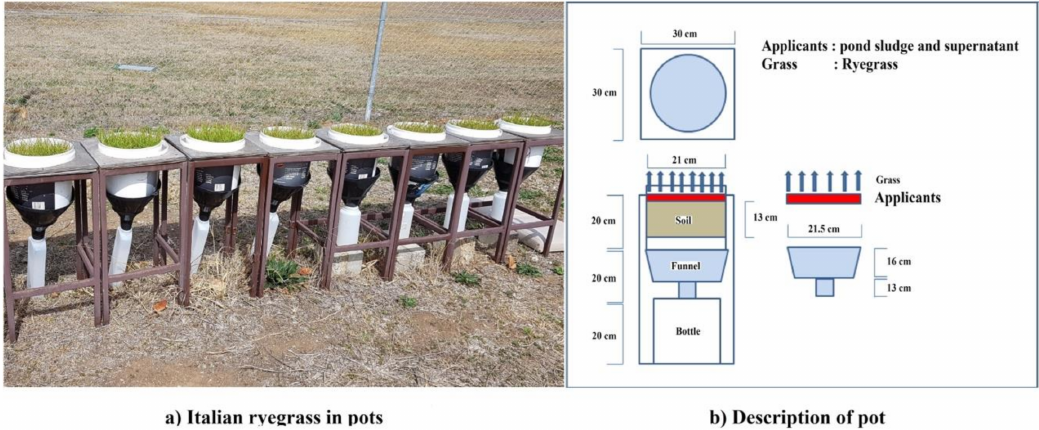
Figure 1. Italian ryegrass in pot experimental set up at Werrington South campus, Western Syd- ney University.